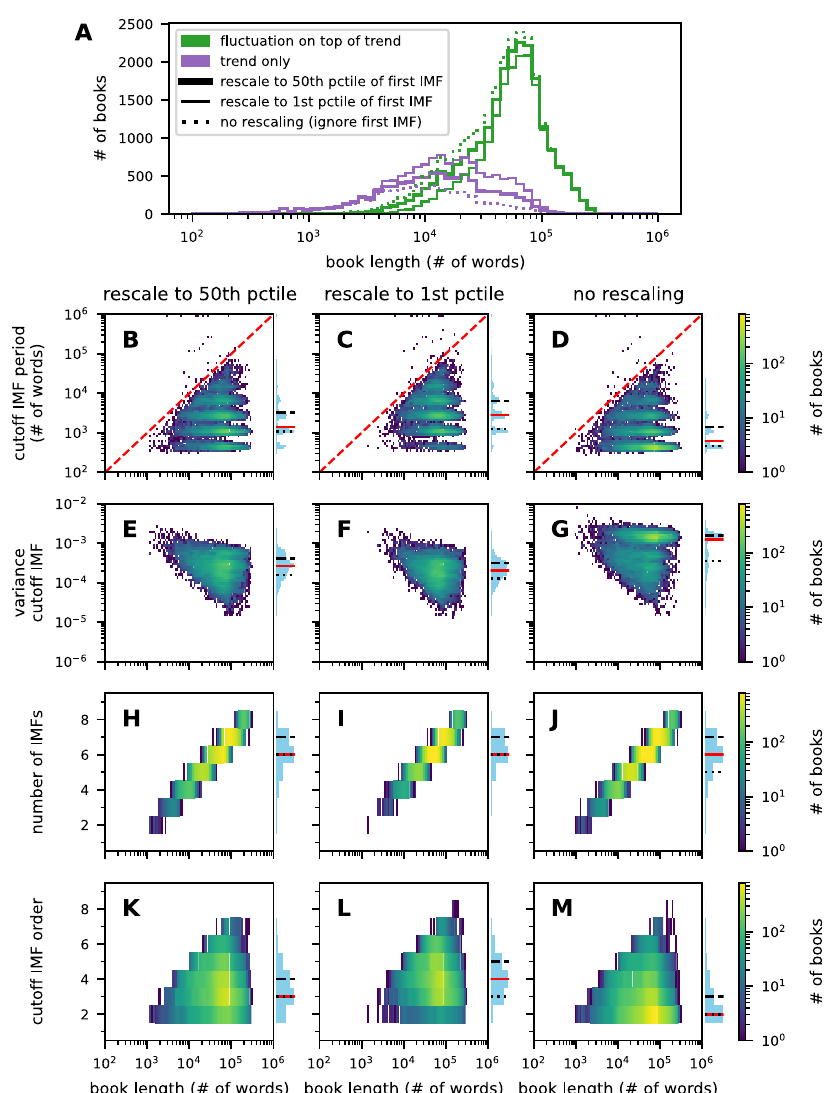
Fig. 6 Characterizing relevant fl uctuations in the danger time series of books in the corpus. A These histograms show the number of books that have fl uctuations on top of the trend (green) and those that do not (purple). The different line widths and line styles correspond to the different rescaling factors: solid thick lines for using the median of the fi rst IMF, solid thin lines for using the 1st percentile of the fi rst IMF, and dotted lines for no rescaling. B – D These are heatmaps that show the relationship between the period of the cutoff IMFs (as the number of words) and the book length for the various rescaling factors (shown above each plot). We can see that most of the points fall below the 45-degree line (red dashed line), indicating that the cutoff IMF period is less than the book length for the vast majority of books. The histograms for the cutoff IMF period are shown on the right side of each plot, with the 25th, 50th, and 75th percentiles shown in dotted black, solid red, and dashed black lines, respectively. The rest of the fi gures are similar to ( B – D ), but for different quantities: variance ( E – G ), number of IMFs ( H – J ; excludes the trend), and cutoff IMF order, with the fi rst IMF counted as 1 ( K – M